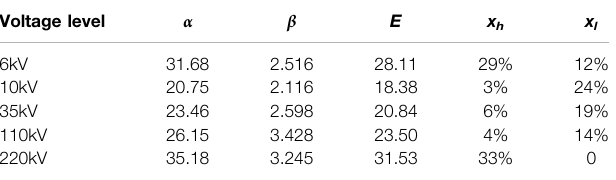
TABLE 2 | Corresponding parameters of equipment at each voltage level. Voltage level